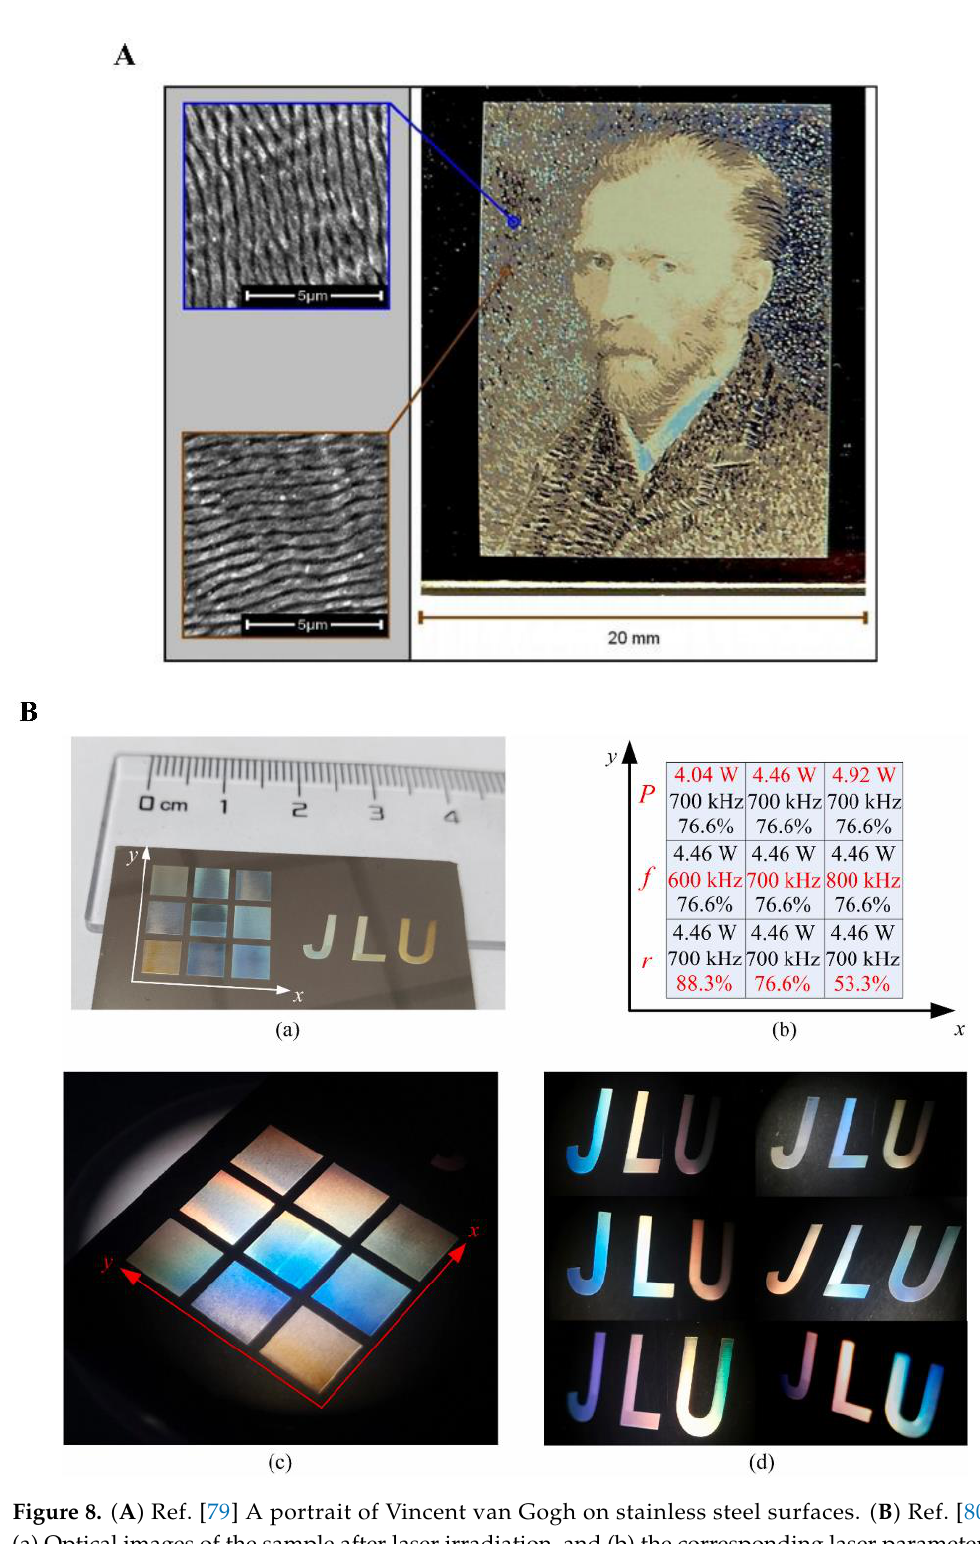
Figure 8. ( A ) Ref. [79] A portrait of Vincent van Gogh on stainless steel surfaces. ( B ) Ref. [80] (a) Optical images of the sample after laser irradiation, and (b) the corresponding laser parameters (P, Laser power; f, Laser repetition frequency; r, Pulse overlap rate between two adjacent scanning lines). (c) shows the optical images “nine-squares” captured in the dark environment, and (d) shows the color change in “JLU” when changing the shooting angle.